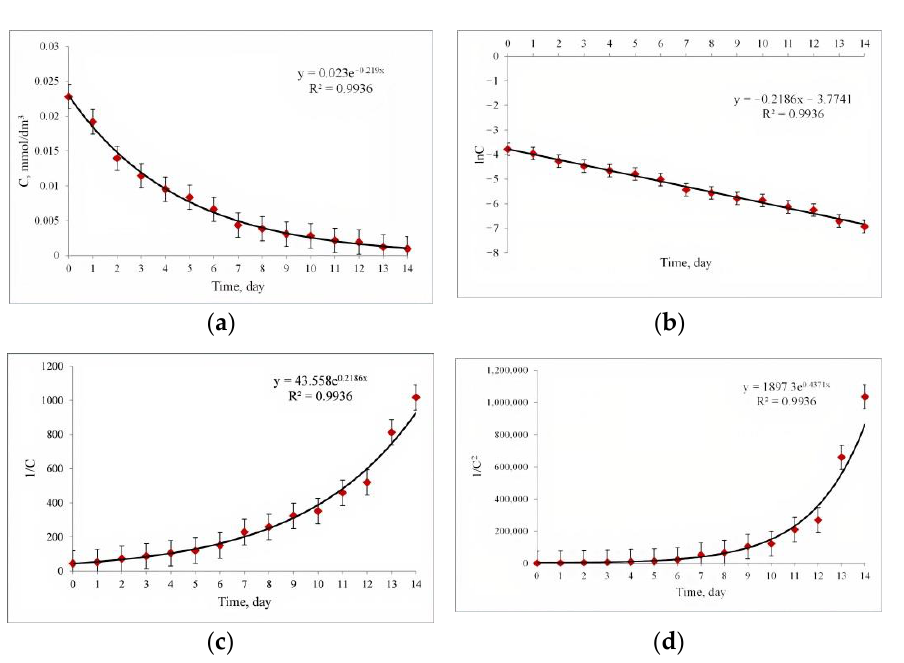
Figure 4. Linear dependence of the initial rate of the biodegradation process of CAPB by the strain Pseudomonas pseudoalcaligenes (B-6783) VSB-10 on the initial surfactant concentration.